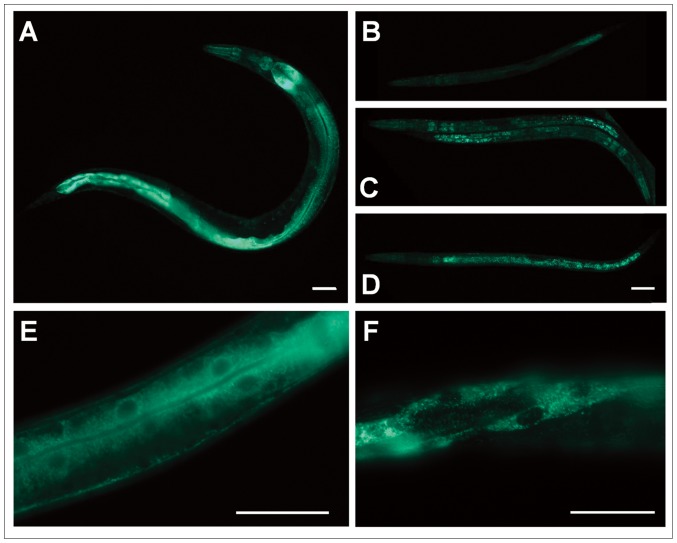
PDHK-2::GFP is highly expressed in starvation and dauer stages.(A) pdhk-2p::PDHK-2::GFP localization in the N2 adult stage. (B) pdhk-2p::PDHK-2::GFP localization in the L3 stage after good nutrition. (C) pdhk-2p::PDHK-2::GFP localization in the L3 stage after 12-hour of starvation. (D) pdhk-2p::PDHK-2::GFP localization in the dauer stage after 7 days of starvation. (E) Intestinal expression of pdhk-2p::PDHK-2::GFP under well-fed conditions at the L4 stage. (F) Muscle expression of pdhk-2p::PDHK-2::GFP in worms starved for 12-hour at the L4 stage. Scale bar: 50 µm.